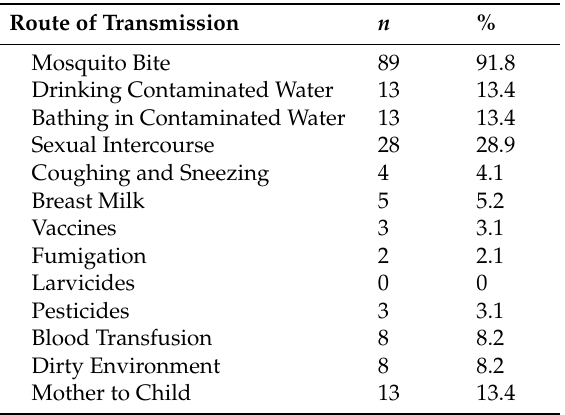
Table A1. Itemized analysis of knowledge about Zika transmission among Latinas of childbearing age in South Florida 2017–2018 ( n = 97).